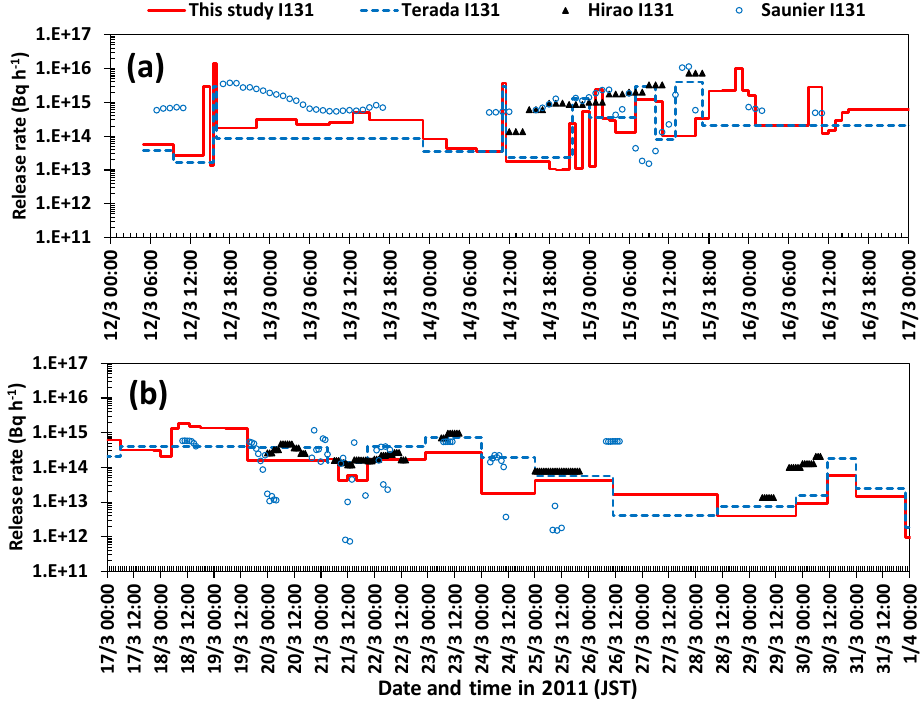
Figure 23. Comparisons of the time varying release rates for total 131 I from 12 March to 1 April 2011 between this study and past studies (Terada et al., 2012; Hirao et al., 2013; Saunier et al., 2013). It is noted that the release rates of Saunier et al. (2013), when the plume directly flowed to the Pacific Ocean, could not be reconstructed